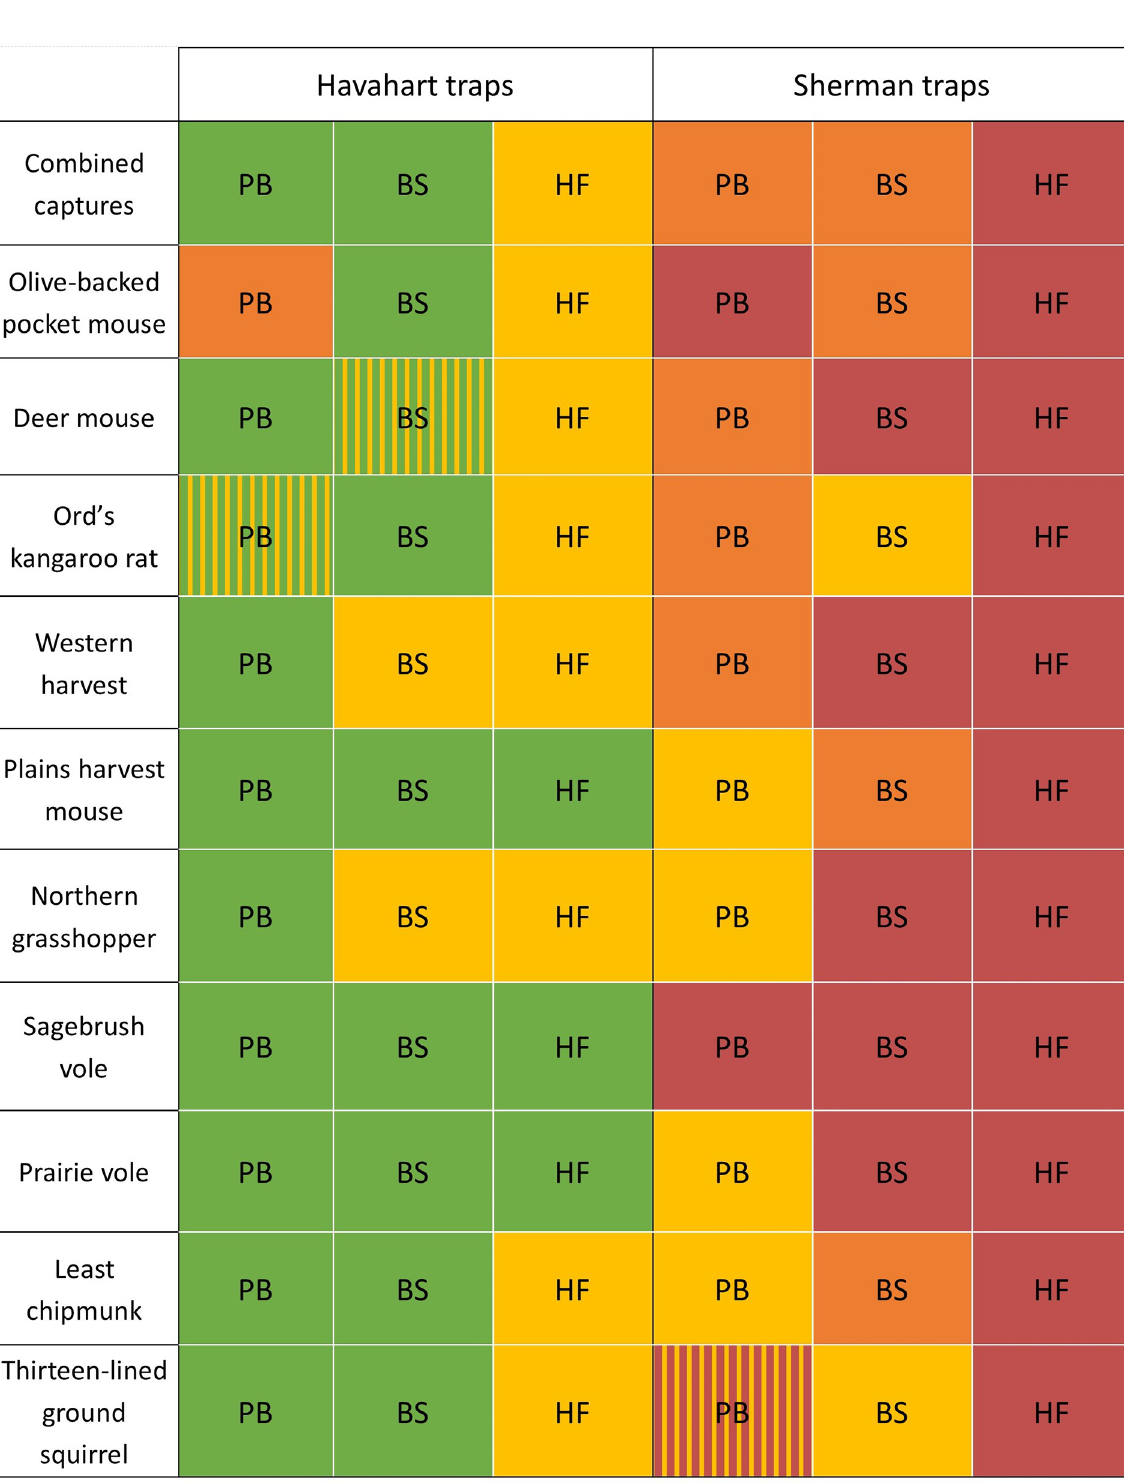
PLOS ONE | https://doi.org/10.1371/journal.pone.0213201 March 5, 2019 8 /